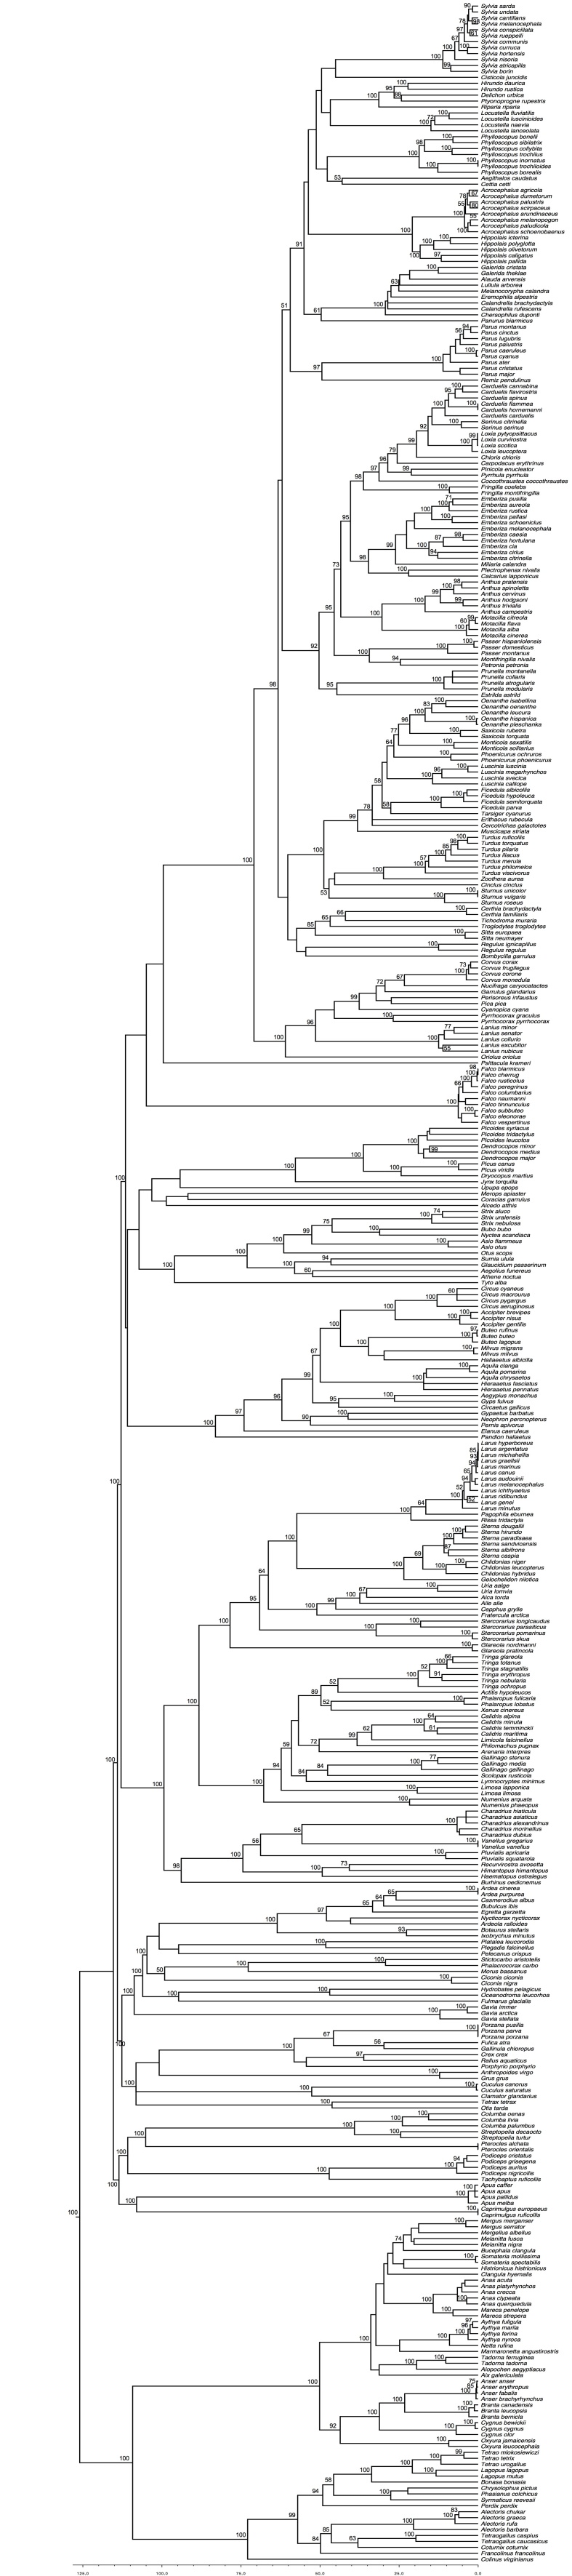
Phylogenetic tree obtained by maximum likelihood inference
withRaxML. Numbers above branches indicate bootstrap values.